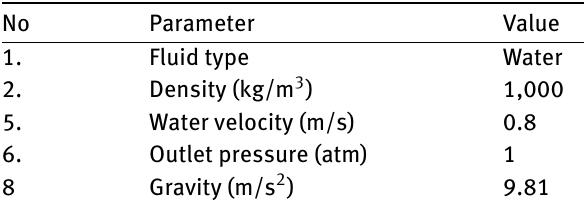
Table 2: Boundary condition of